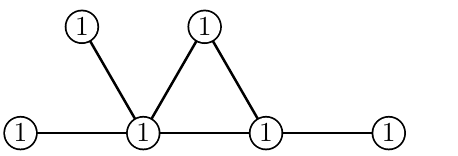
Figure 2. A local inclusive distance vertex irregular labeling of a graph G